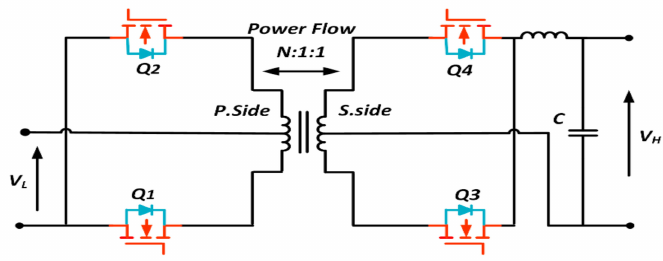
Figure 16. Isolated push–pull bidirectional DC-DC converter [18].